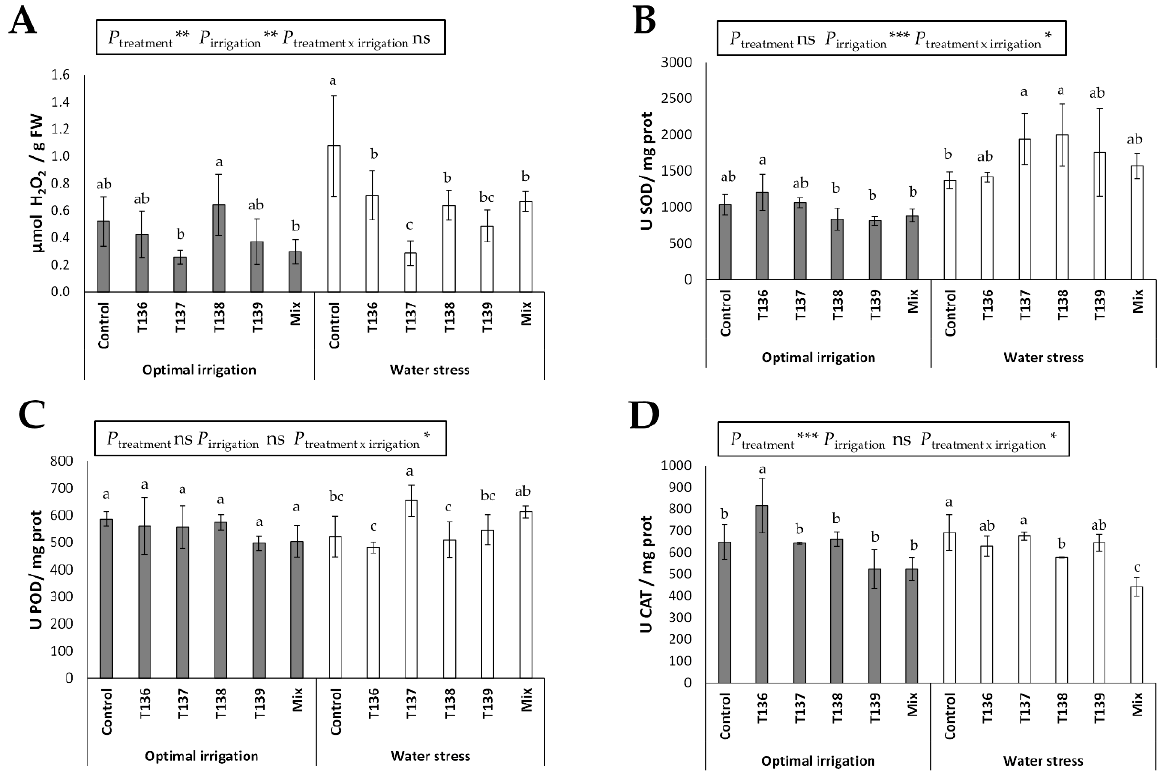
Figure 5. Effect of Trichoderma ( T. harzianum T136, T. simmonsii T137, T. afroharzianum T138, T. harzianum T139, and a mixture with these four strains) treatments on ( A ) H 2 O 2 content, and ( B ) SOD, ( C ) POD, and ( D ) CAT activities in 40-day-old wheat plants that were grown under optimal irrigation and water stress (irrigation was removed for 2.5 weeks when plants were 21 days old) conditions. The data were calculated from four replicates for each treatment and condition ( n = 4), and different letters above the bars indicate significant the differences according to one-way analysis of variance (ANOVA) followed by Duncan’s test ( p < 0.05). For each set of data, the effect of significance was determined by a two-way ANOVA for Trichoderma treatment, irrigation condition, and the combination treatment per irrigation condition (***: p < 0.001; **: p < 0.01; * p < 0.05; ns: no statistical differences). FW: leaf fresh weight.